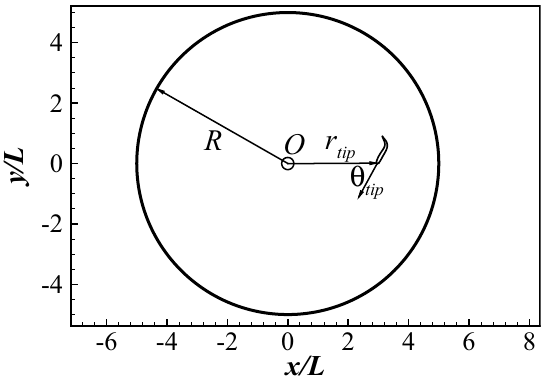
Figure 6. The confined domain of the point-to-point